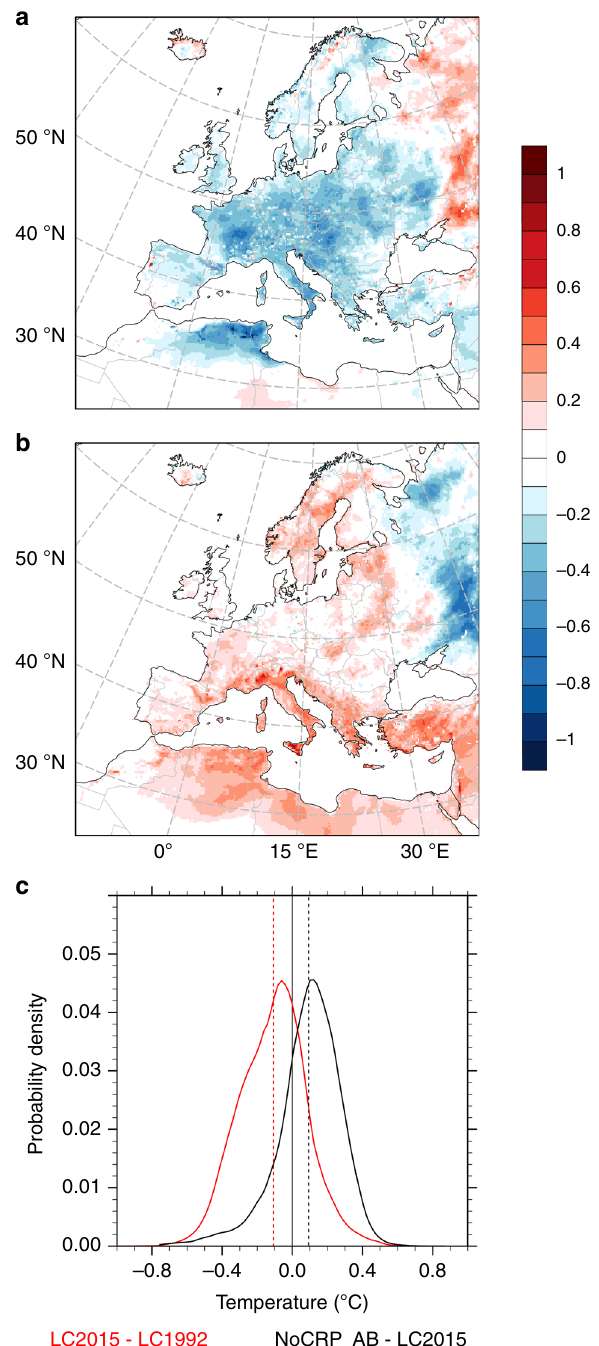
Fig. 2 Annual average temperature changes from recent (1992 – 2015) land cover transitions in Europe. Annual average temperature changes (°C) due to differences in land cover between 1992 and 2015 ( a ); annual average temperature changes excluding contributions from agriculture abandonment ( b ); probability density function of the annual average temperature changes across the entire domain ( c ). In c , the solid line shows the distribution of the values and the dashed vertical line indicates the respective mean value. LC1992 and LC2015 refer to regional climate simulations with the European land cover in 1992 or 2015, respectively. NoCRP_AB refers to a land cover dataset where agricultural land in 1992 is not allowed to convert to other land